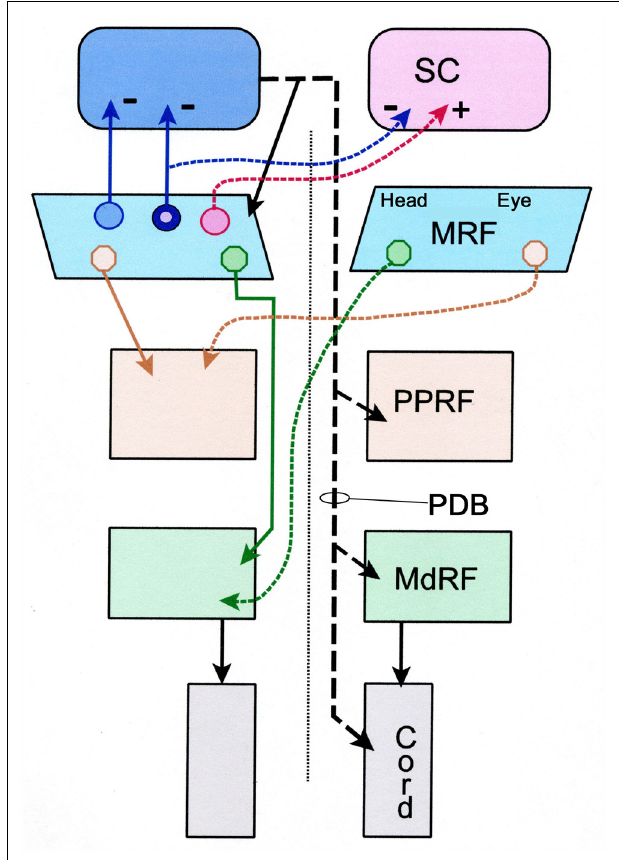
FIGURE 9 | Schematic diagram showing the pattern of projections of the central portion of the mesencephalic reticular formation (cMRF) to the superior colliculus (SC), and the pontine reticular formation (PRF) and medullary reticular formation (MdRF). The medial head and the lateral eye regions of the cMRF are indicated for the descending projections.The descending projection from the superior colliculus is the predorsal bundle (PDB). Dashed lines indicate crossed projections.The known excitatory and inhibitory pattern of reticulotectal projections is indicated by + and − , respectively.The reticulotectal neuron projecting to both colliculi has blue cytoplasm and a pink nucleus signifying its appearance when the cytoplasm is labeled with one tracer and the nucleus